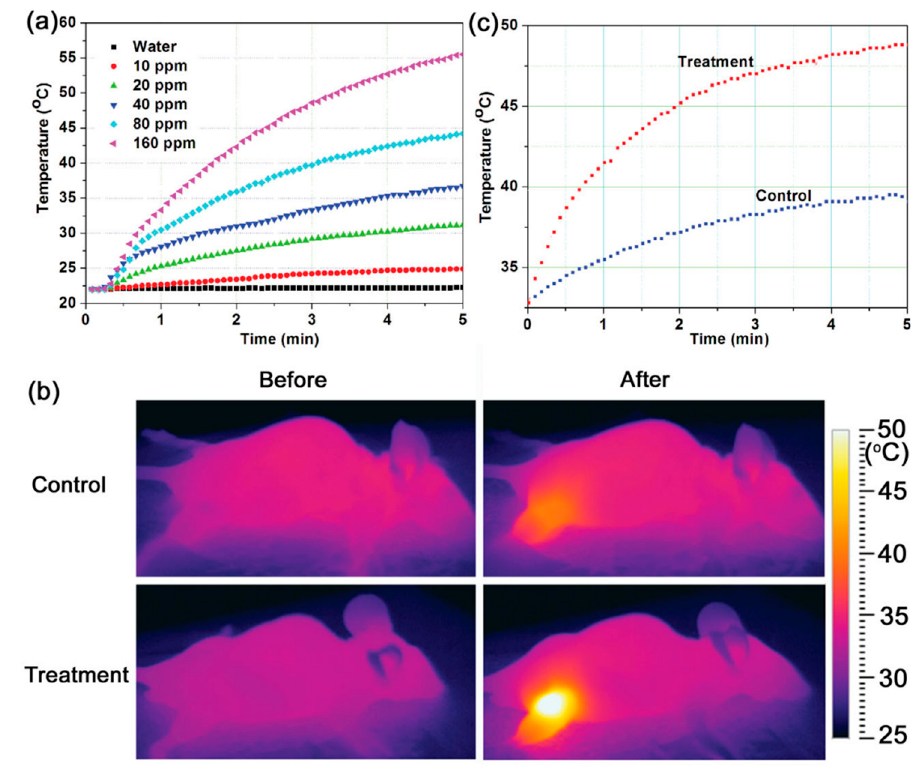
Figure 5. ( a ) Temperature profiles of pure water and aqueous dispersions of ION@polypyrrole (PPY) with different particle concentrations (10, 20, 40, 80, and 160 ppm) as a function of irradiation time; ( b ) infrared thermal images of the tumor-bearing mice injected with 100 µL of phosphate buffer (control) and 80 ppm ION@PPY (treatment) before and after irradiation for 5 min; ( c ) the temperature profiles of the tumor (irradiated) regions in the control and the treatment as a function of the irradiation time. An 808 nm laser with a power density of 0.25 W·cm − 2 was used for the irradiation. Reprinted with permission from Small 10 (6), 1063–1068. Copyright 2014 [90].